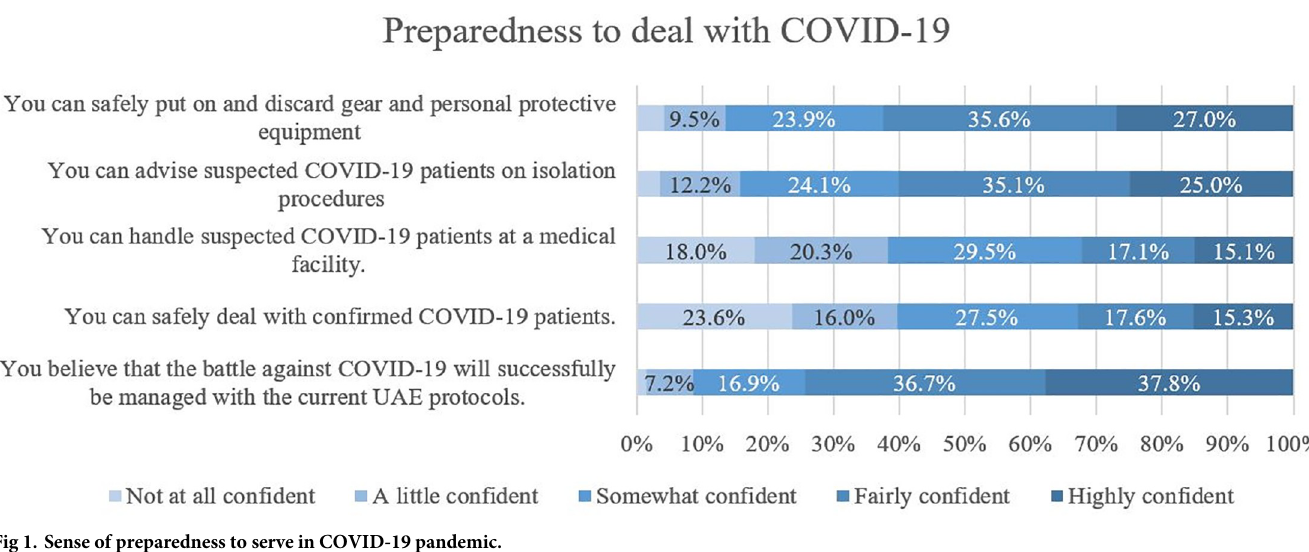
from Table 2: age-groups, city of residence, professional status, years of clinical experience, patient contact and workshops attended in the past year. The regression analysis yielded an adjusted R square of 0.384 and thus, the model was significant in predicting 38.4% of the total variability in the dependent knowledge score. (F = 38.033, p < 0.001).